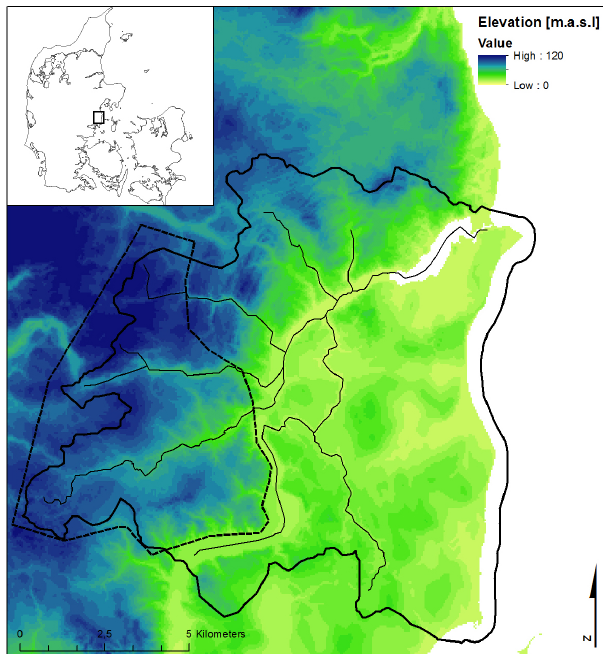
Figure 1. Insert: the study site in eastern Jutland, Denmark. Main image: the Norsminde catchment with the delineated glacial struc- ture in the western part of the catchment and, additionally, the river network and the